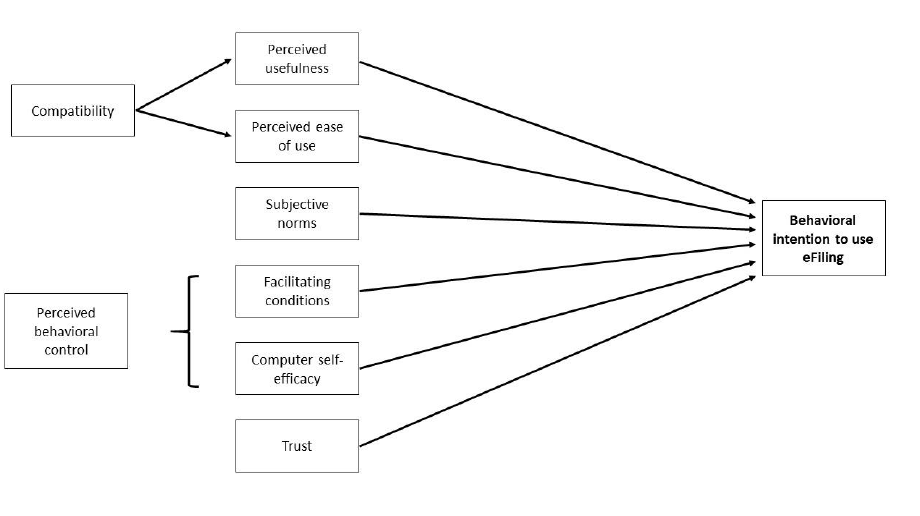
FIGURE 1: Research model Source: Authors’